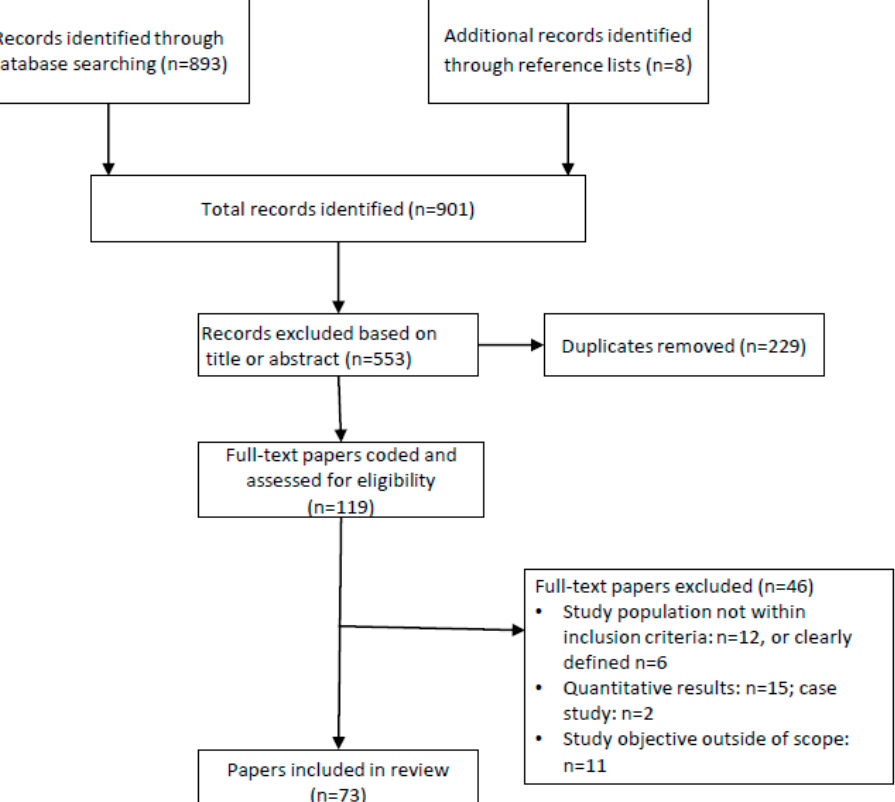
Figure 1. Systematic review flow diagram for study selection.